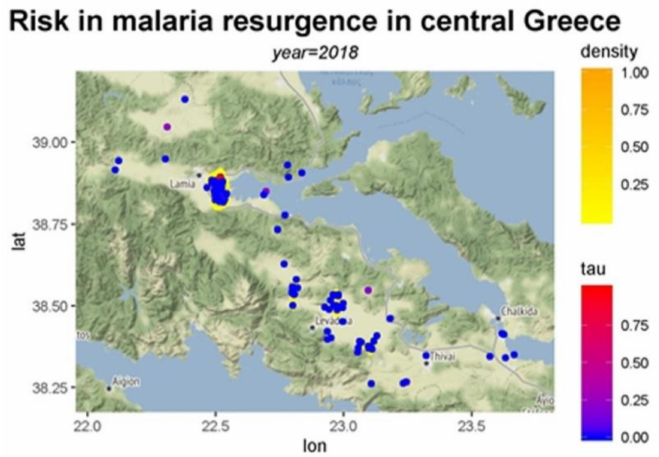
Figure A5. Heat-map of risk of malaria transmission ( τ estimates).